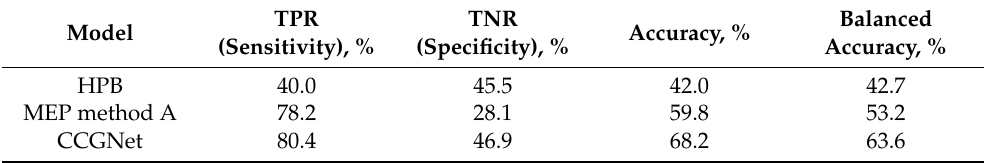
Figure 2. Receiver operating characteristic (ROC) curves and AUC values for four prediction models for the CBZ-coformer dataset. Table 1. Prediction performances of the selected models on the CBZ-coformer